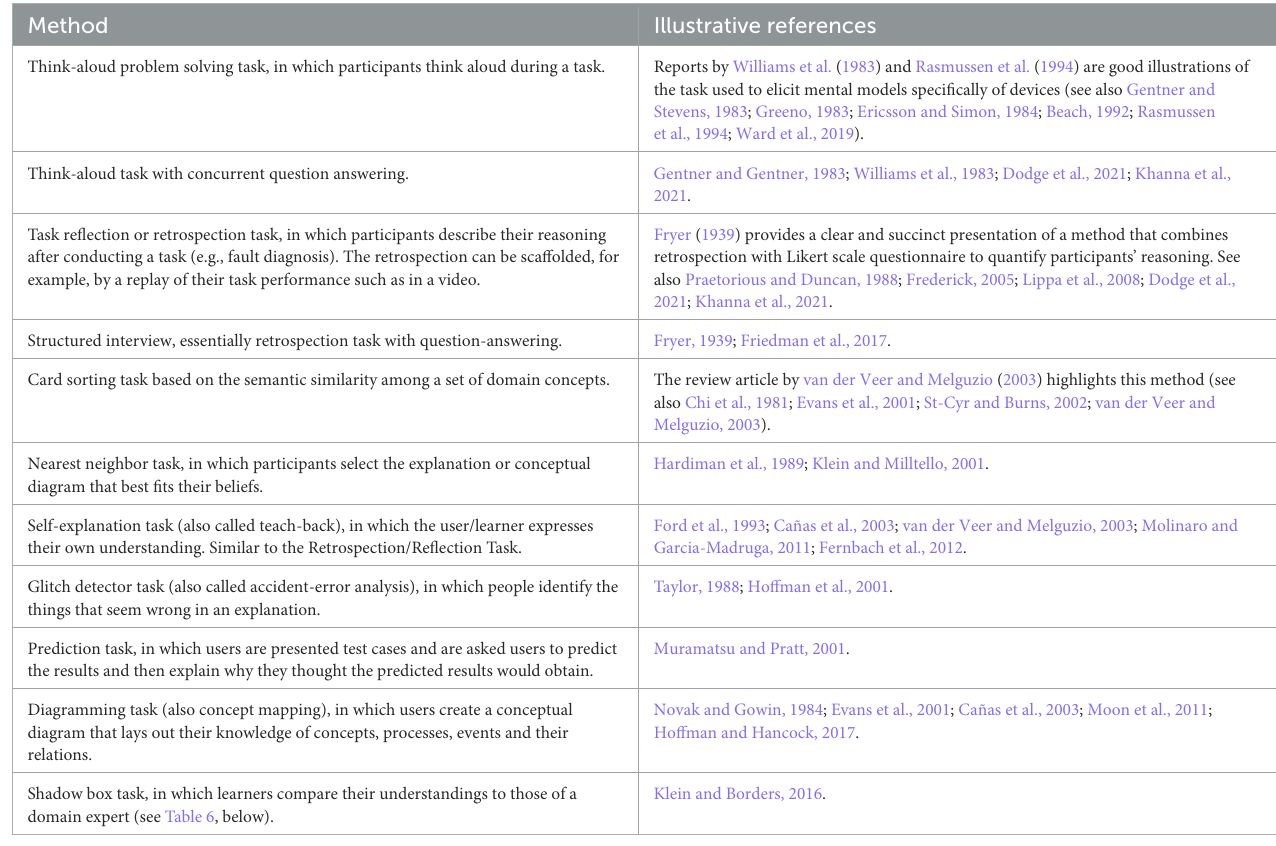
TABLE 4 Some methods that can be used to elicit mental models.